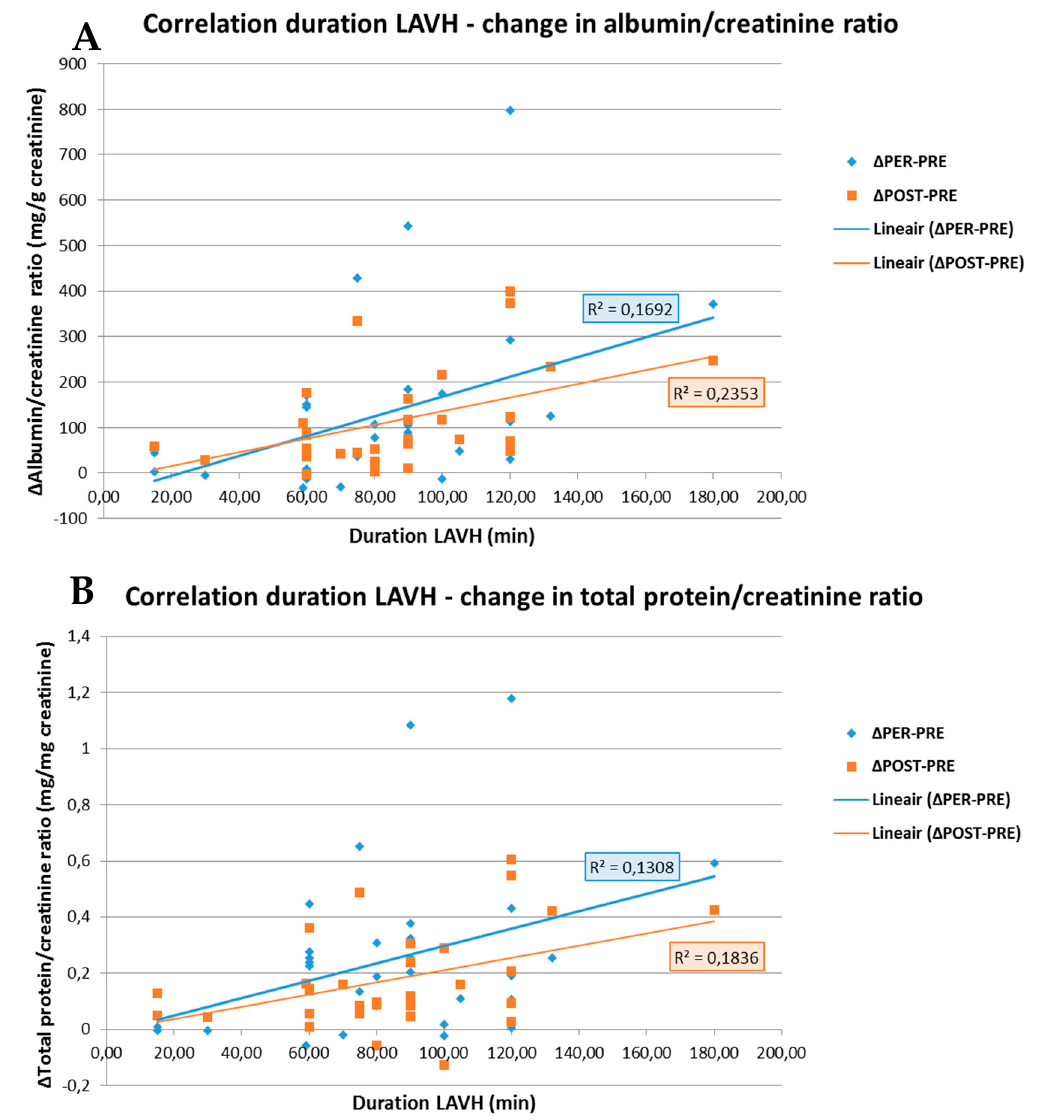
Figure 3. Correlation between the duration of the LAVH procedure and the change in albumin / creatinine ratio ( A ) and in total protein / creatinine ratio ( B ) PRE- to PER- and PRE- to POST-procedure. A positive correlation is observed between the duration of the LAVH procedure and the change in albumin / creatinine ratio ( A ) and total protein / creatinine ratio ( B ) from PRE- to PER-procedure, i.e., blue line (R = 0.411; p = 0.019 and R = 0.362; p = 0.042, respectively). The same is observed for the duration of the LAVH procedure and the change in albumin / creatinine ratio ( A ) and total protein / creatinine ratio ( B ) PRE- to POST-procedure, i.e., orange line (R = 0.485; p = 0.005 and R = 0.429; p = 0.014, respectively). R: Pearson correlation coefficient.